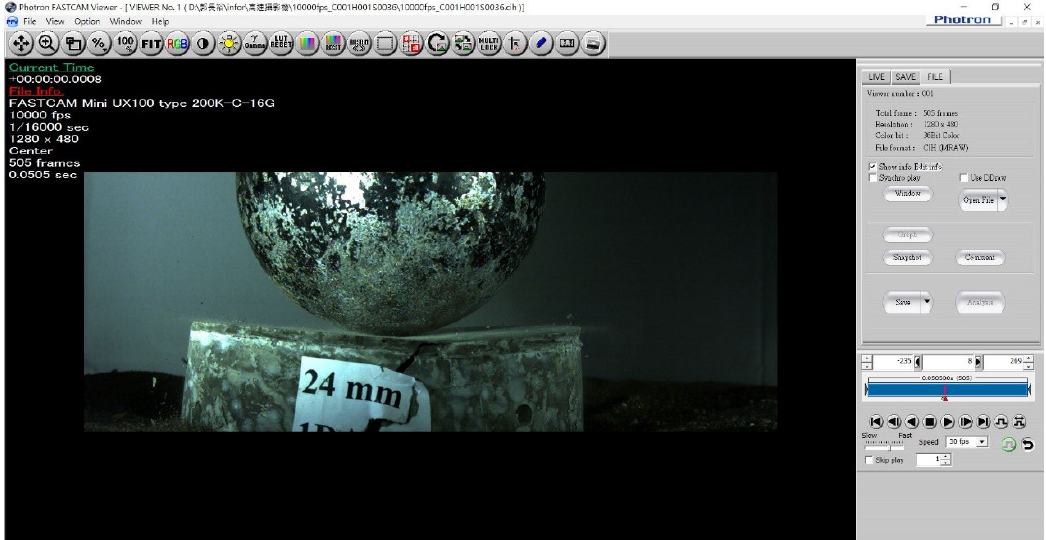
Figure 12. The image of benchmark specimen after the steel ball impact taken by high speed camera.